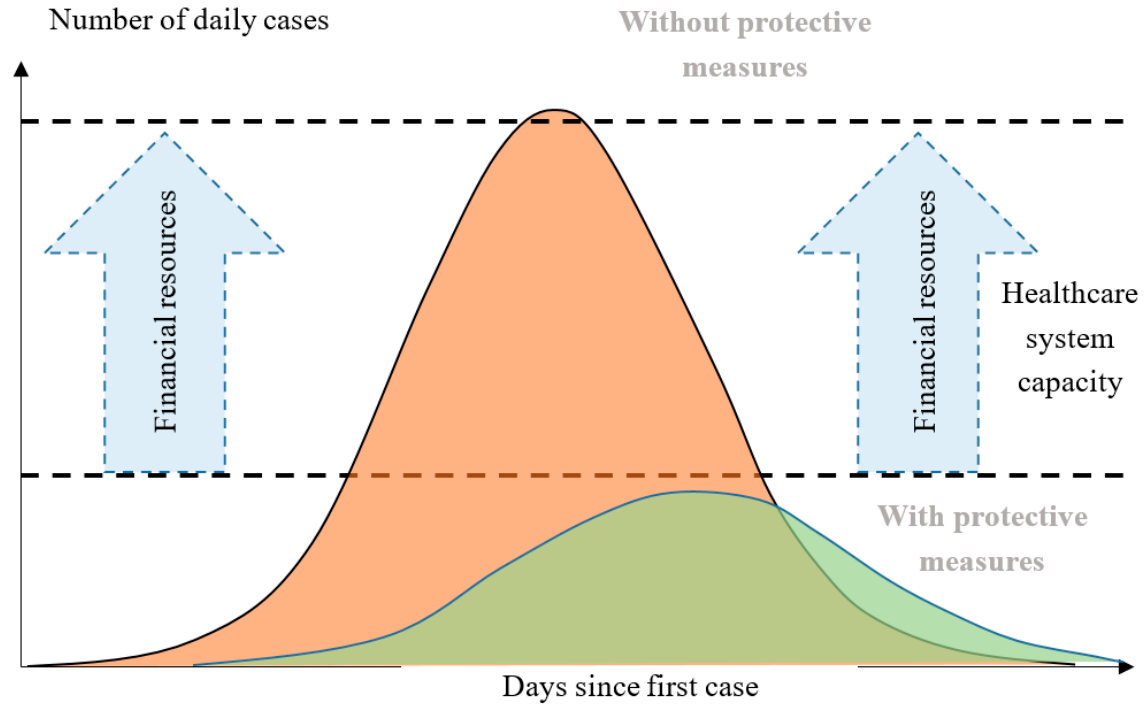
Figure 3. Refining of medical surge capacity with the use of financial resources.